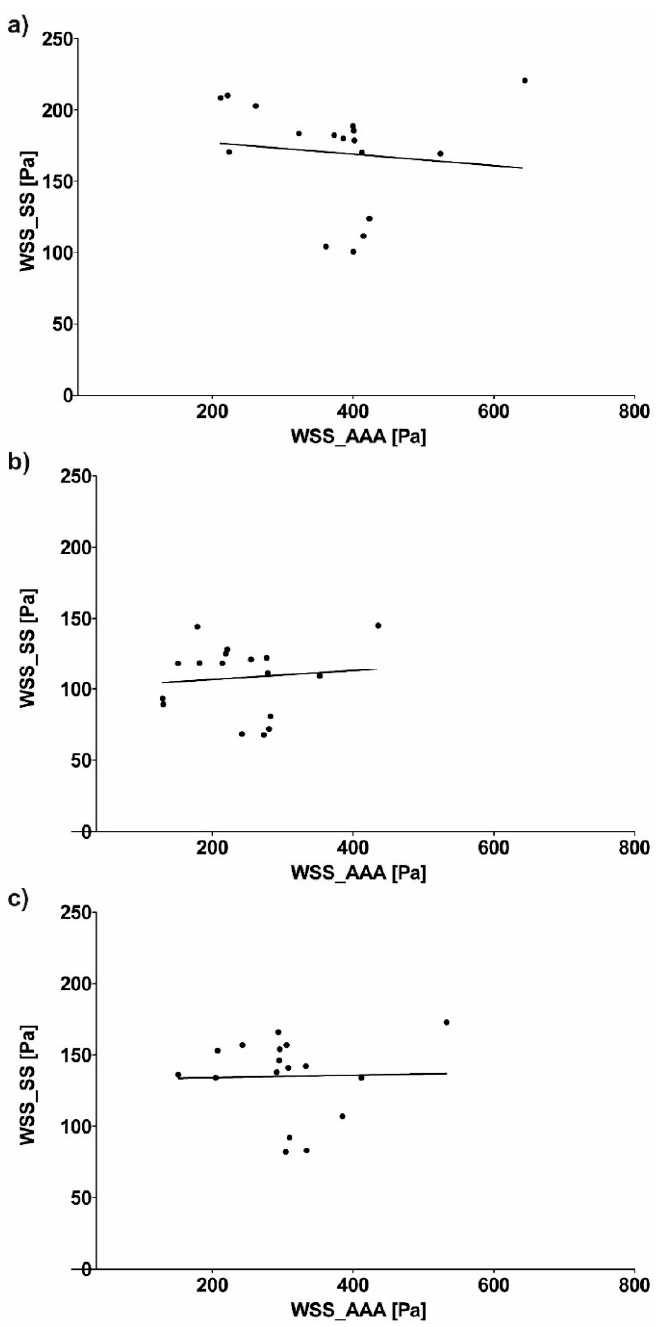
Figure 10. Scatterplot graphic representation of Pearson’s correlation factors rho [-] for the analyzed WSS_SS in function of WSS_AAA for: ( a ) Sharp profile (rho = − 0.1171, p = 0.6544), ( b ) flat profile (rho = 0.098, p = 0.706), ( c ) real profile (rho = 0.0262, p = 0.920).